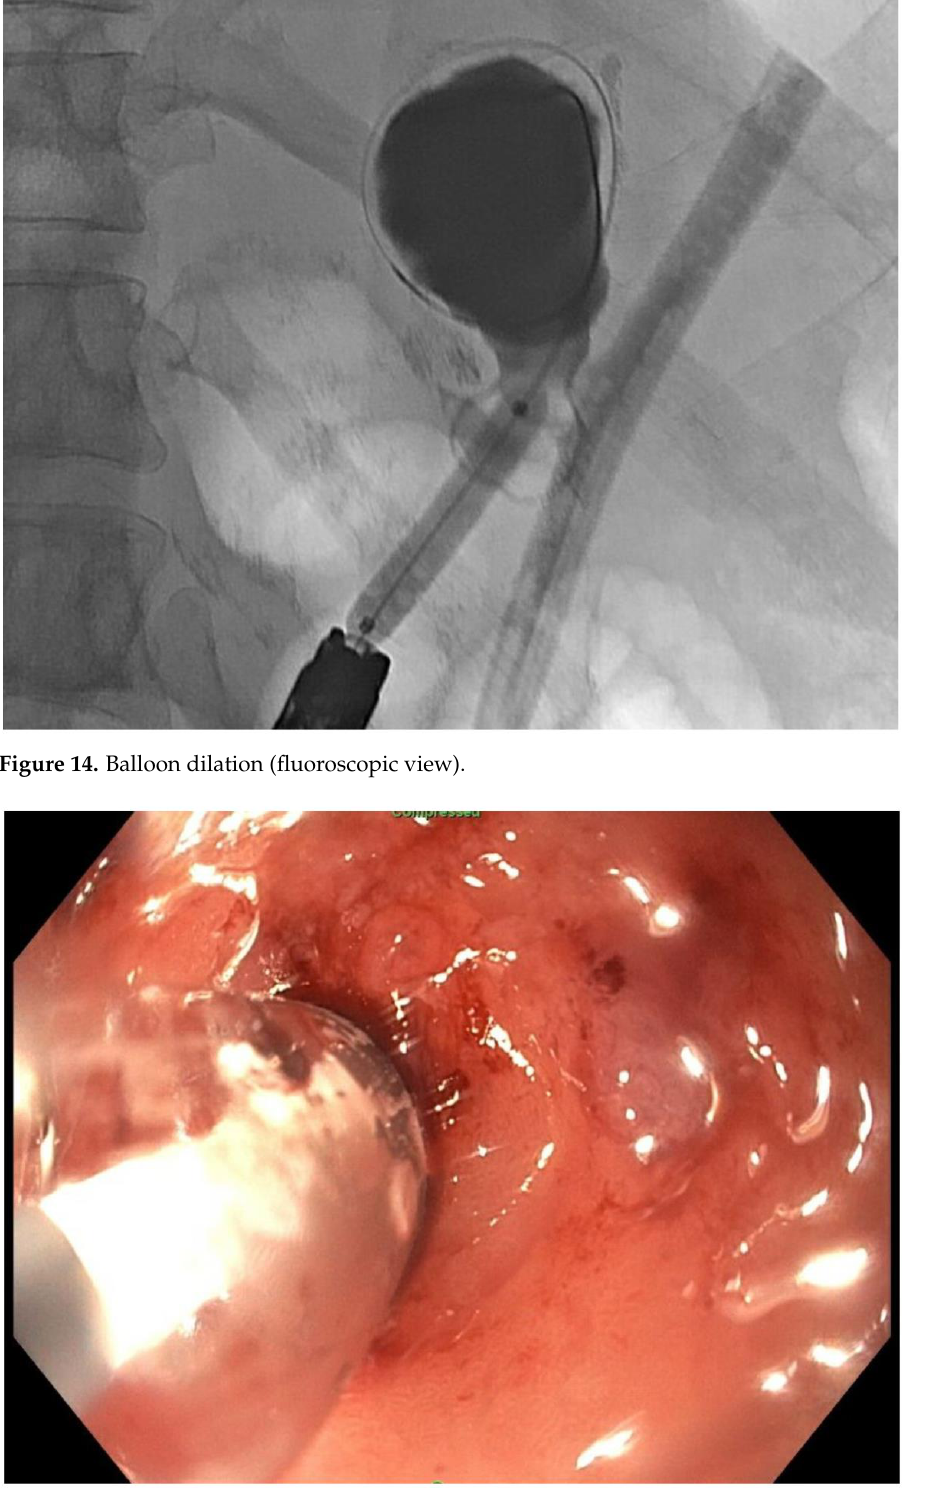
Figure 15. Dilating the balloon.